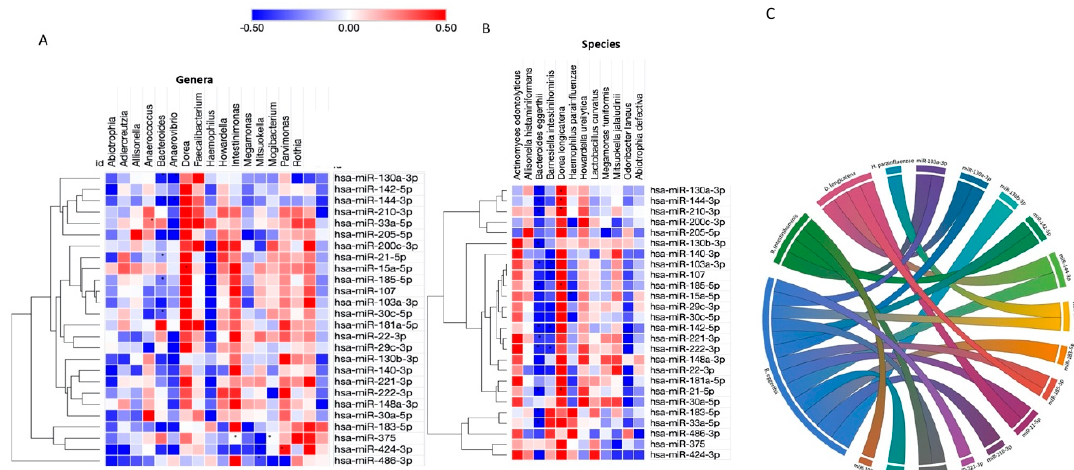
Figure 3. Correlation between miRNA and gut microbiota (genera and species) significantly associated with obesity. ( A ) Heatmap showing the correlations between bacterial genera (in columns) and di ff erently expressed miRNAs (in rows). ( B ) Heatmap showing the correlation between bacterial species (in columns) and di ff erently expressed miRNAs (in rows). MiRNAs were clustered using the one minus Pearson correlation with average linkage. Positive correlations were shown in red and negative correlations in blue, with brighter shades indicating higher correlations. Lack of correlations is represented in white. Statistically significant correlations were marked with asterisks (*). ( C ) Chord diagram demonstrating interaction between microRNAs and bacterial species. This figure was performed using MORPHEUS and